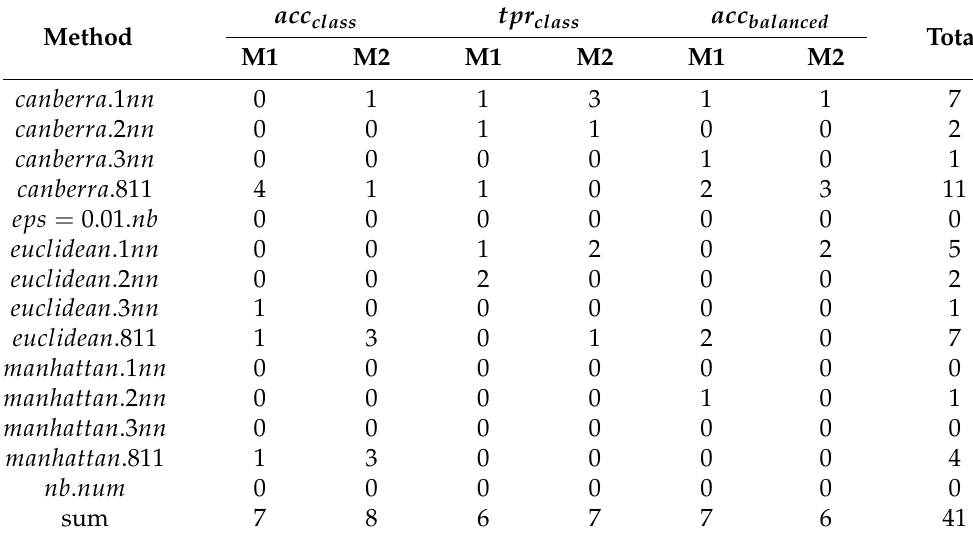
Table 7. The effectiveness of individual classifiers expressed as a number indicating how many times a specific test produced the highest value of acc klass , tpr class ,or acc balanced in all comparisons of class vs. other.